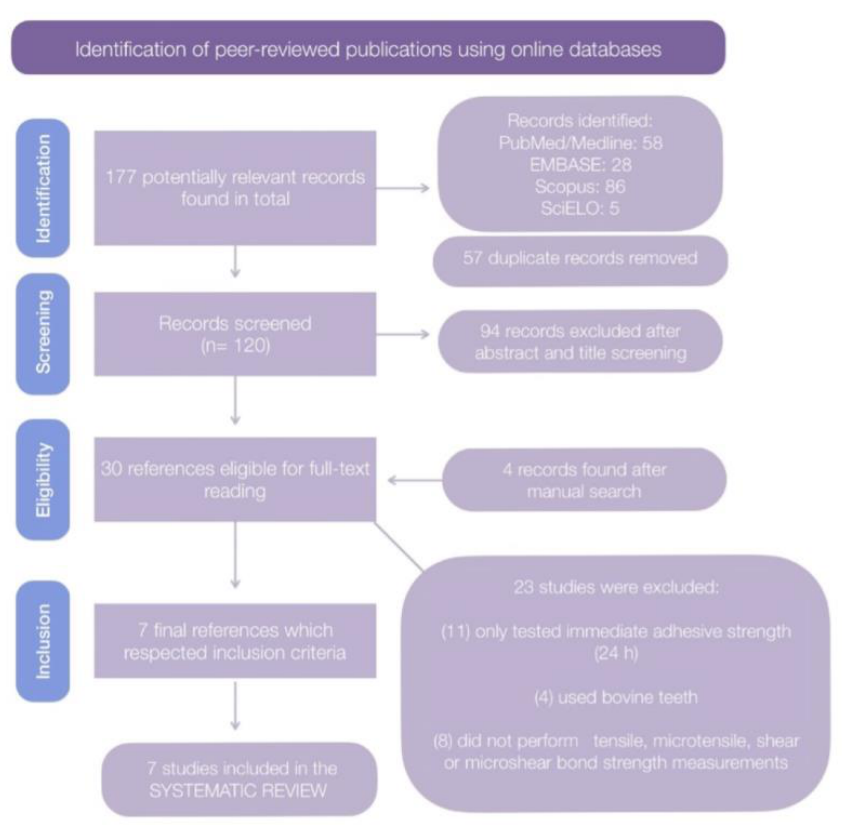
Figure 1. Flowchart in compliance with the PRISMA statement guidelines, showing the steps followed in each stage of the systematic review. Out of 177 potentially relevant papers, after screening, eligibility, and inclusion, 7 remained.